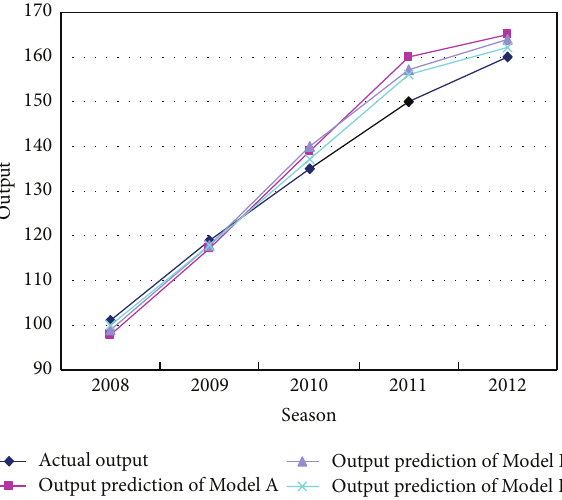
Figure 3: Line chart of output predictions and actual